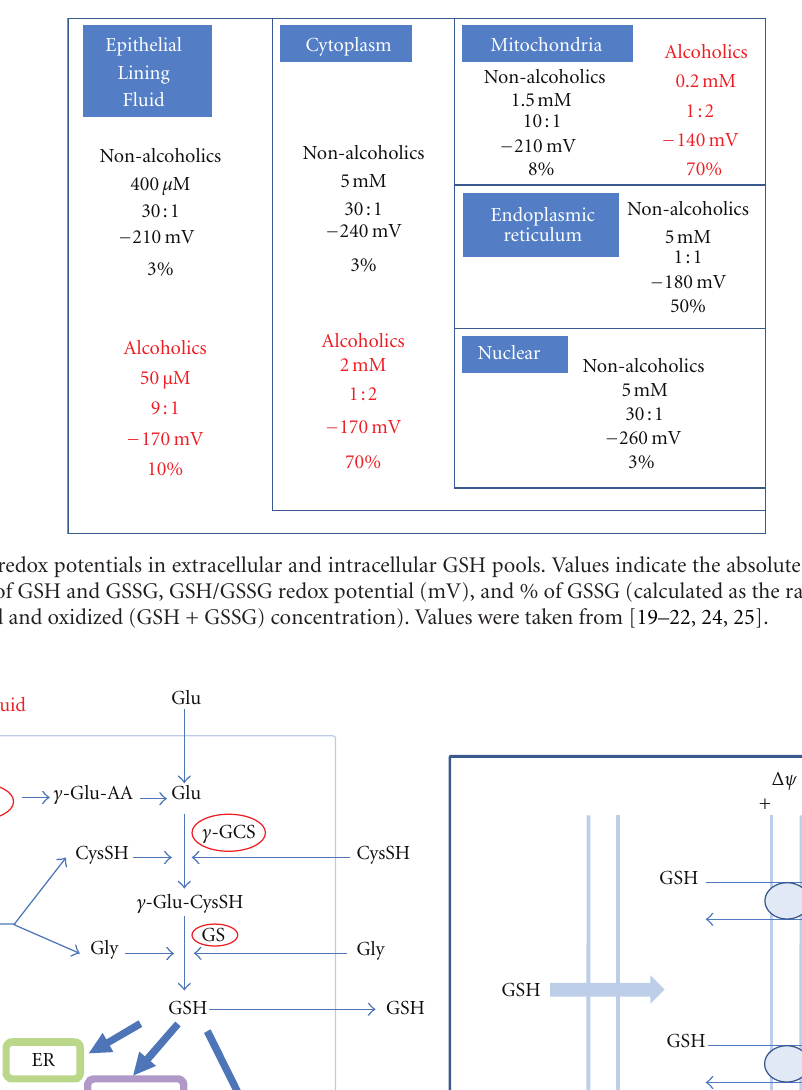
against hydrolyzation by most peptidases that catalyze the cleavage of α -carboxyl peptide bonds. Rather, the γ -carboxyl peptide bond is cleaved by γ -glutamyltransferase ( γ -GT) on the external surface of certain cell types (Figure 3). This cleavage produces γ -glutamyl amino acid ( γ -Glu-AA), which